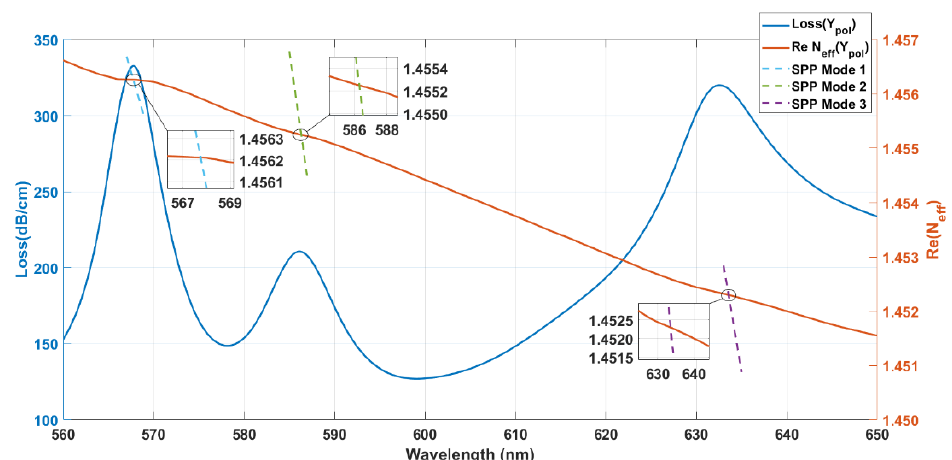
Figure 2. Dispersion curve of the fundamental fiber mode and SPP modes for a variable refractive index with parabolic profile analyte Ri analyte = 7.41 × 10 − 6 λ 2 − 0.0083 λ + 3.65. Y pol is the perpen- dicular polarization to the gold slabs. The insets show the intersections between the dispersion curve of the fundamental Y pol fiber mode and the plasmonic mode at the gold interfaces.